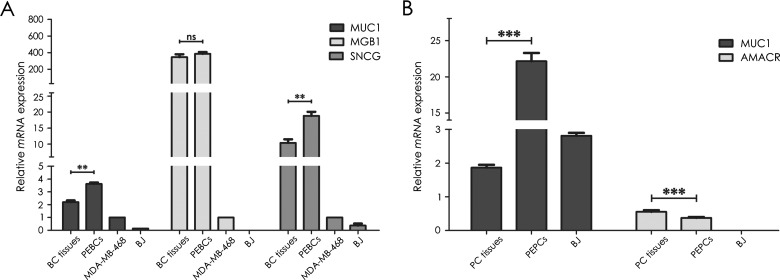
Analysis of specific markers expression at mRNA level(A) MUC1/Y, MGB1 and SNCG expression in BC tissues compared with PEBCs. (B) MUC1/Y and AMACR expression in PC tissues compared with PEPCs; Analysis was performed for each successfully established sample, averaged expression level is provided. Error bars indicate SEM; **P  <0.01, ***P  <0.001, ns–not statistically significant.